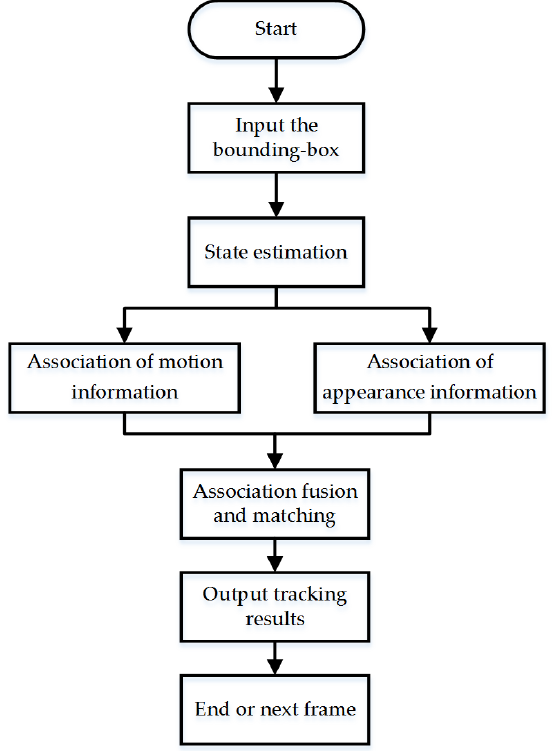
Figure 4. Deep SORT tracking framework.